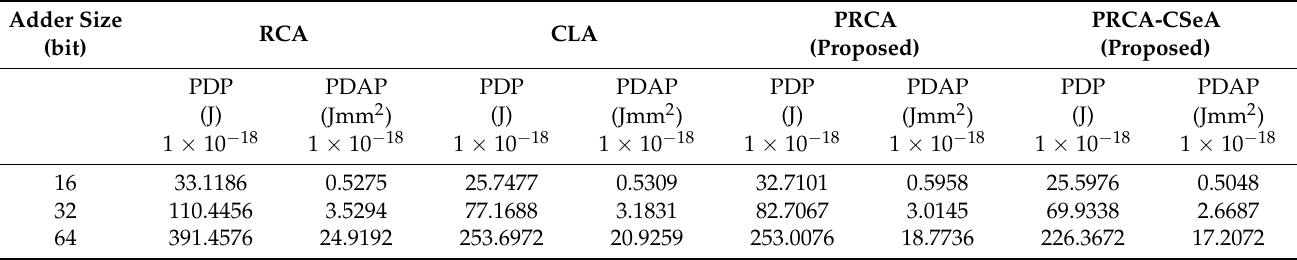
Table 5. Power–delay product (PDP) and power-delay-area product (PDAP) for conventional RCA, CLA, proposed PRCA, and case three of our PRCA-CSeA